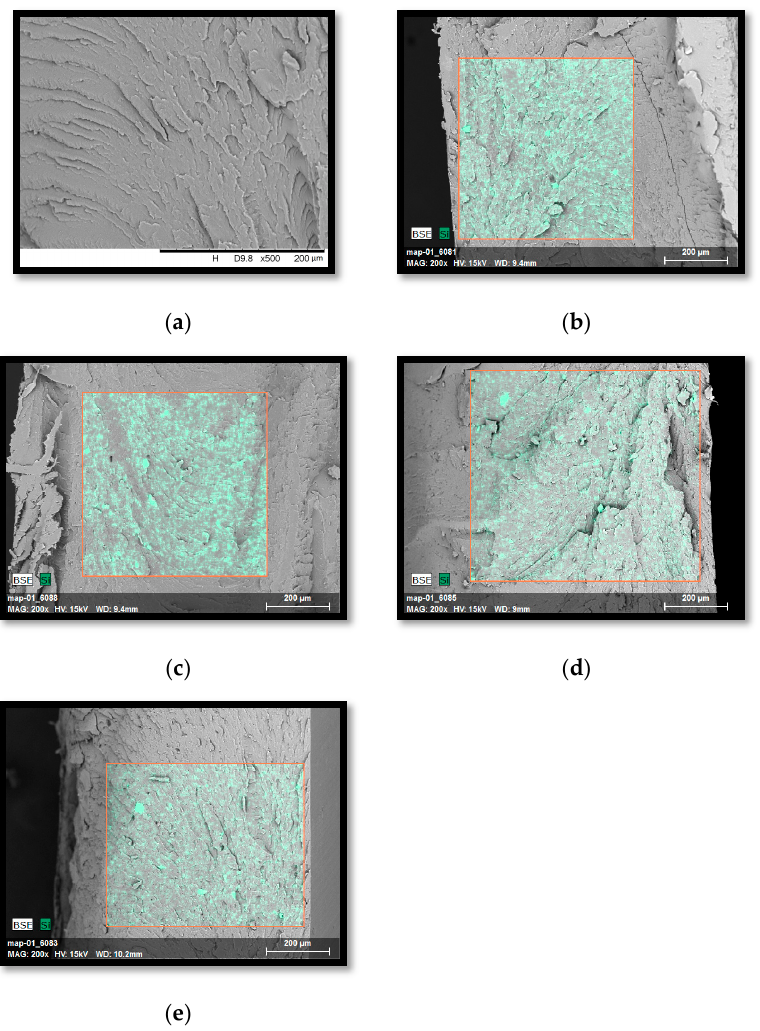
Figure 7. SEM micrographs with the EDS adapter of the PC/ABS blend and composites based on it: ( a ) PC/ABS, ( b ) PC/ABS/3%S, ( c ) PC/ABS/3%B, ( d ) PC/ABS/3%L, ( e ) PC/ABS/1.5%L/1.5%B. The red contour marks the area subjected to EDS analysis, which was performed in order to observe the degree of dispersion of the filler and the distribution of the silicon element.